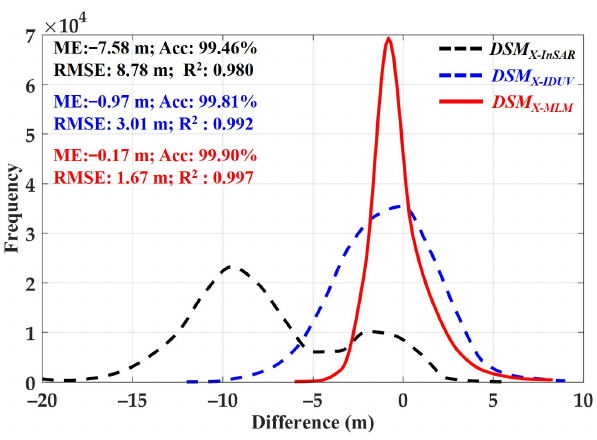
Figure 14. Histograms of the DSM differences ( DSM X-InSAR/IDUV/MLM minus DSM LiDAR ).